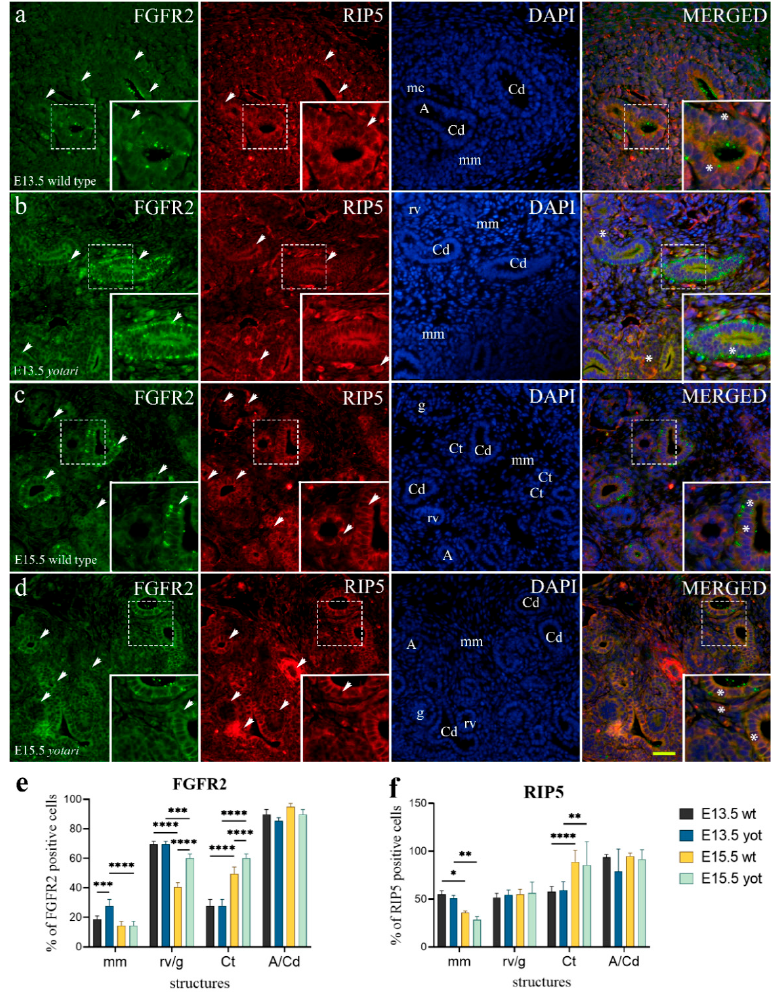
Figure 3. Double immunofluorescence staining of embryonic wild-type and yotari mouse kidneys with the FGFR2 and RIP5 markers ( a – d ). Arrows show the expression pattern of FGFR2 and RIP5 in metanephric mesenchyme (mm), renal vesicles (rv), glomeruli (g), convoluted tubules (Ct), ampullae (A), and collecting ducts (Cd) indicated on 4 ′ ,6-diamidino-2-phenylindole (DAPI) image. Immunoexpression of FGFR2, RIP5, 4 ′ ,6-diamidino-2-phenylindole (DAPI) staining and merged FGFR2, RIP5, and DAPI at embryonic days E13.5 and E15.5 in wild type ( a , c ) and yotari ( b , d ). The most prominent protein expression area is shown in inserts, corresponding to the dashed boxes. An asterisk denotes the zone where co-expression was detected. Images were taken on magnification ×40. The scale bar is 50 μ m, which refers to all images. The distribution of the percentages of FGFR2 ( e ), and RIP5 ( f ) positive cells in the metanephric mesenchyme (mm), renal vesicles (rv) or glomeruli (g), convoluted tubules (Ct), and ampulla (A) or collecting ducts (Cd) of wild type and yotari kidneys at embryonic days E13.5 and E15.5. Data are presented as the mean ± SD (vertical line) and analyzed by a two-way ANOVA test followed by Tukey’s multiple comparison test. Significant differences were indicated by * p < 0.05, ** p < 0.001, *** p < 0.0001, **** p < 0.00001. At each time point, ten substructures were